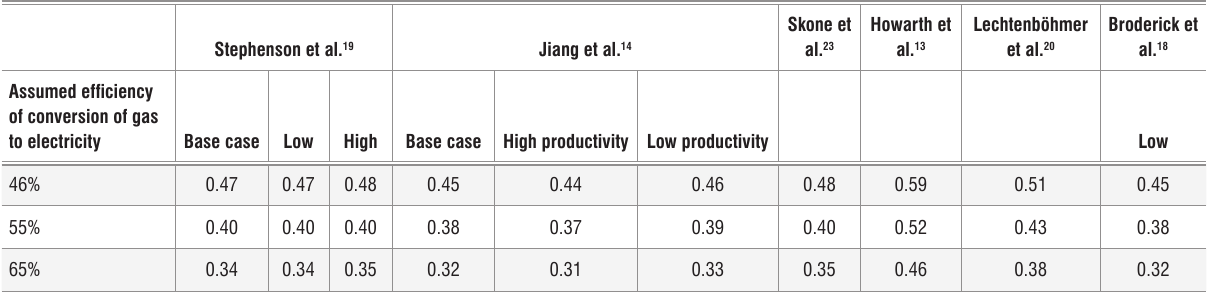
Stephenson et al. 19